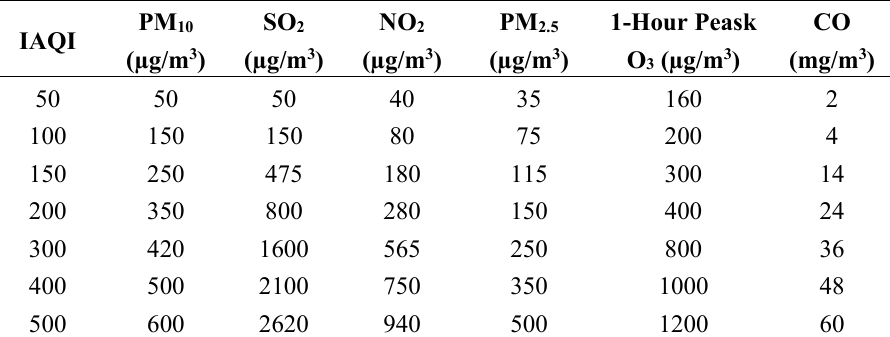
Table 2. Concentration limits for air quality index (AQI)